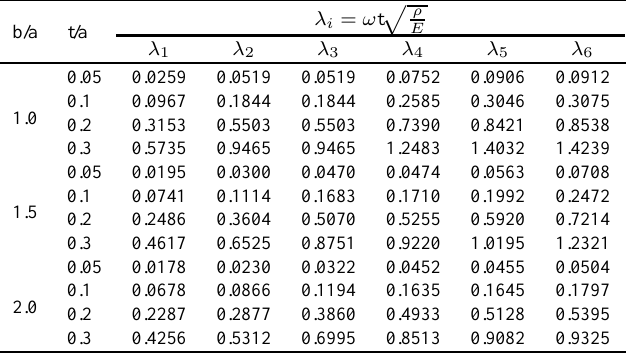
Table 2 The first six natural frequency parameters of thick clamped thick plates